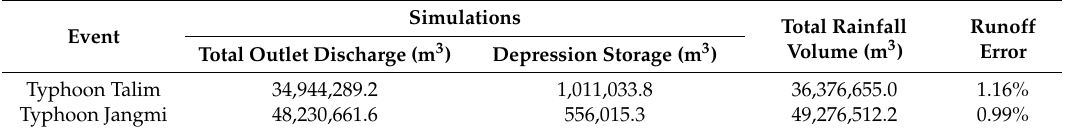
Figure 6. Simulation results of runoff at the outlet of the study area and the corresponding rainfall: ( a ) Typhoon Talim and ( b ) Typhoon Jangmi. Table 3. The comparison of the runoff volumes for different typhoon events.